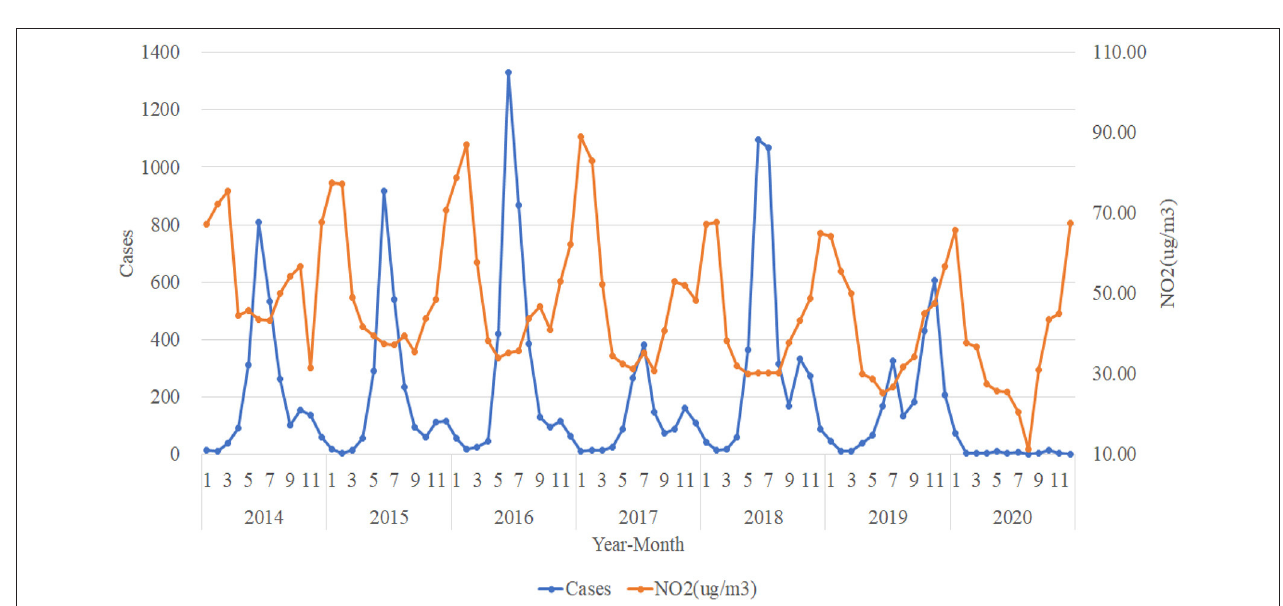
FIGURE 7 | Trends in the number of HFMD cases and NO 2 (ug/m 3